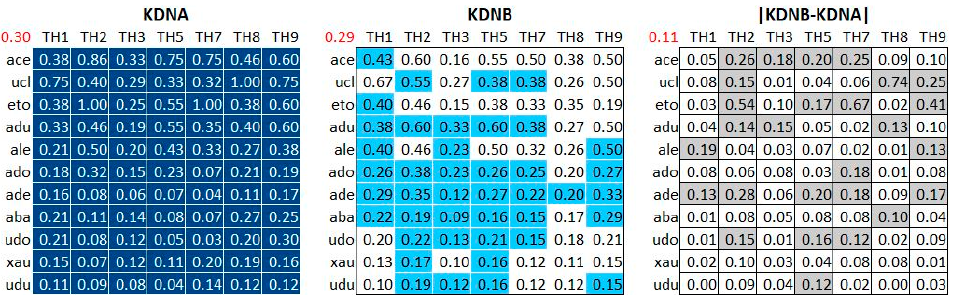
Figure 18. Comparison of the proximities with topic hubs for 11 guests. KDNA = proximities measured through the guests’ trails. KDNB = proximities measured through the others’ trails. The KDNA proximities are computed by using only the targeted guests’ trails; for instance: “the proximity between ‘ale’ and ‘TH1’ is 0.21” means that “ale” has through his own viewpoints opened trails leading from himself to “TH1”, which results in yielding a K-proximity of 0.21.